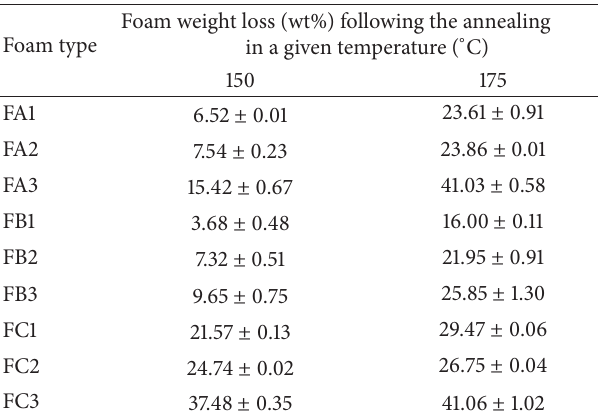
Table 7: Foams weight loss following the 30-day